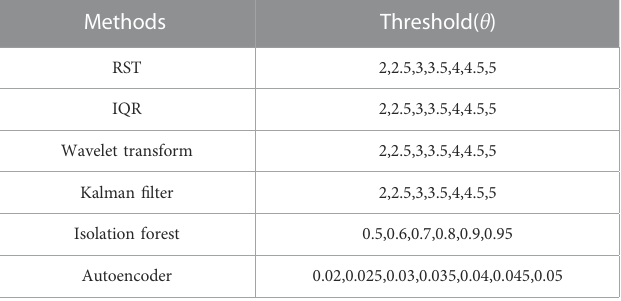
TABLE 1 The thresholds of the different methods. Methods Threshold( θ